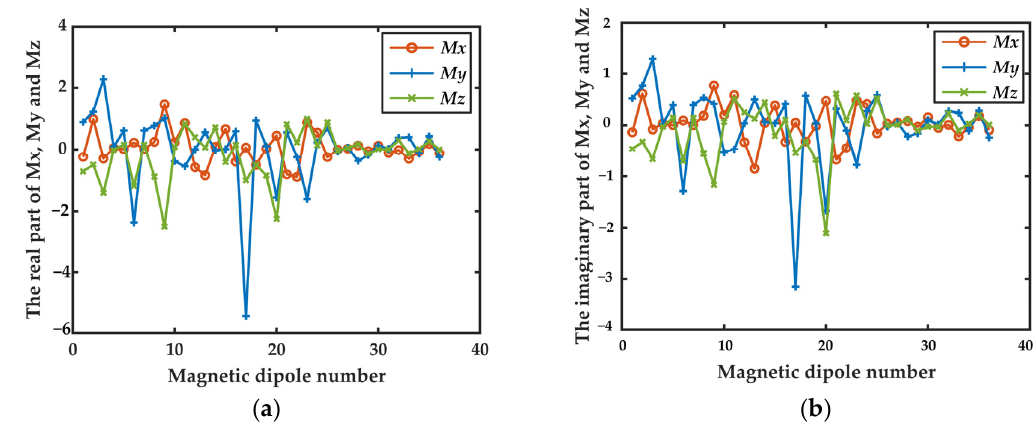
Figure 13. The values of the real and imaginary parts of the magnetic dipole moment. ( a ) The values of the real part of the magnetic dipole moment; ( b ) The values of the imaginary part of the magnetic dipole moment.